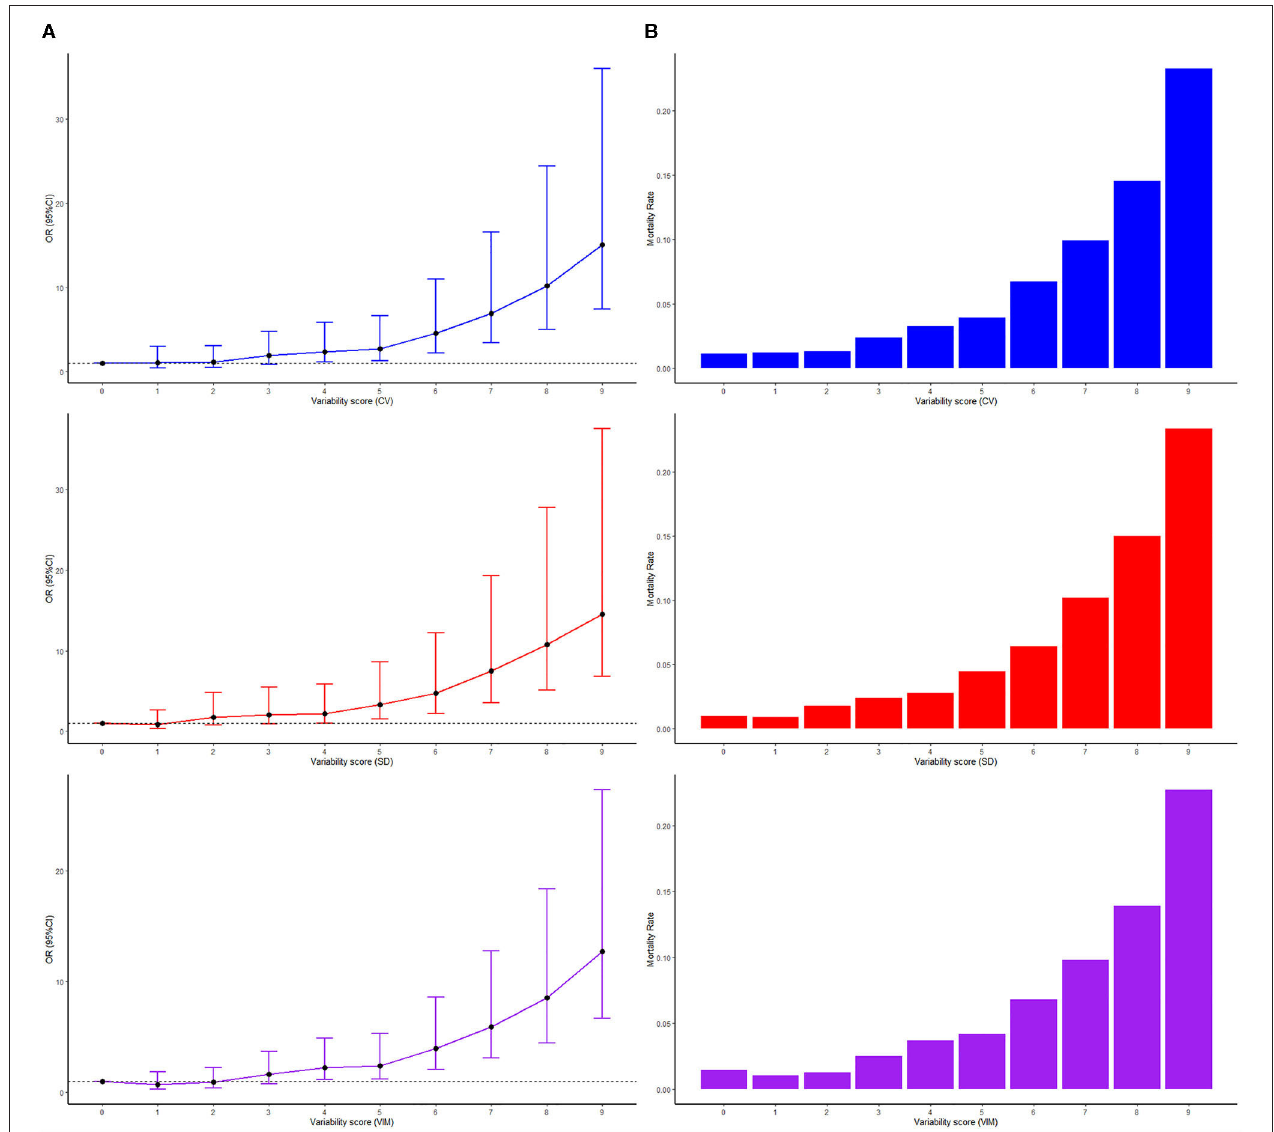
FIGURE 1 | A positive linear association between the variability score and (A) odds ratios and 95% confidence interval for the in-hospital mortality (line charts) and (B) the in-hospital mortality (bar